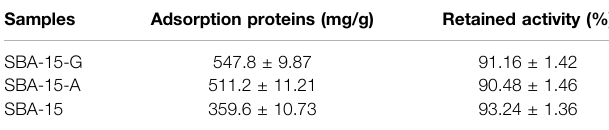
TABLE 2 | The maximum adsorption amount and remained activity of Mb onto SBA-15, SBA-15-G, and SBA-15-A.